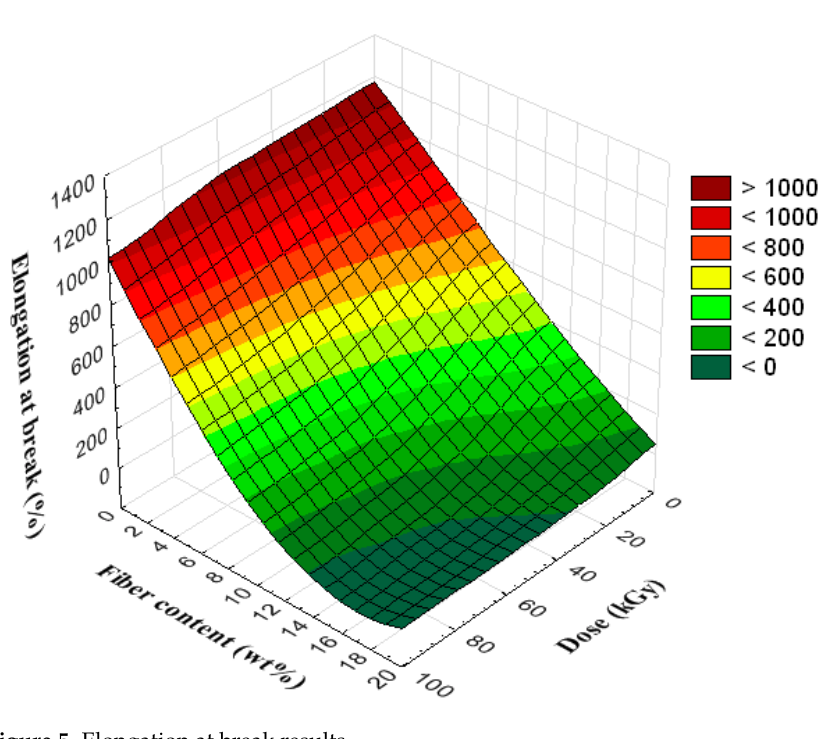
Figure 5. Elongation at break results.